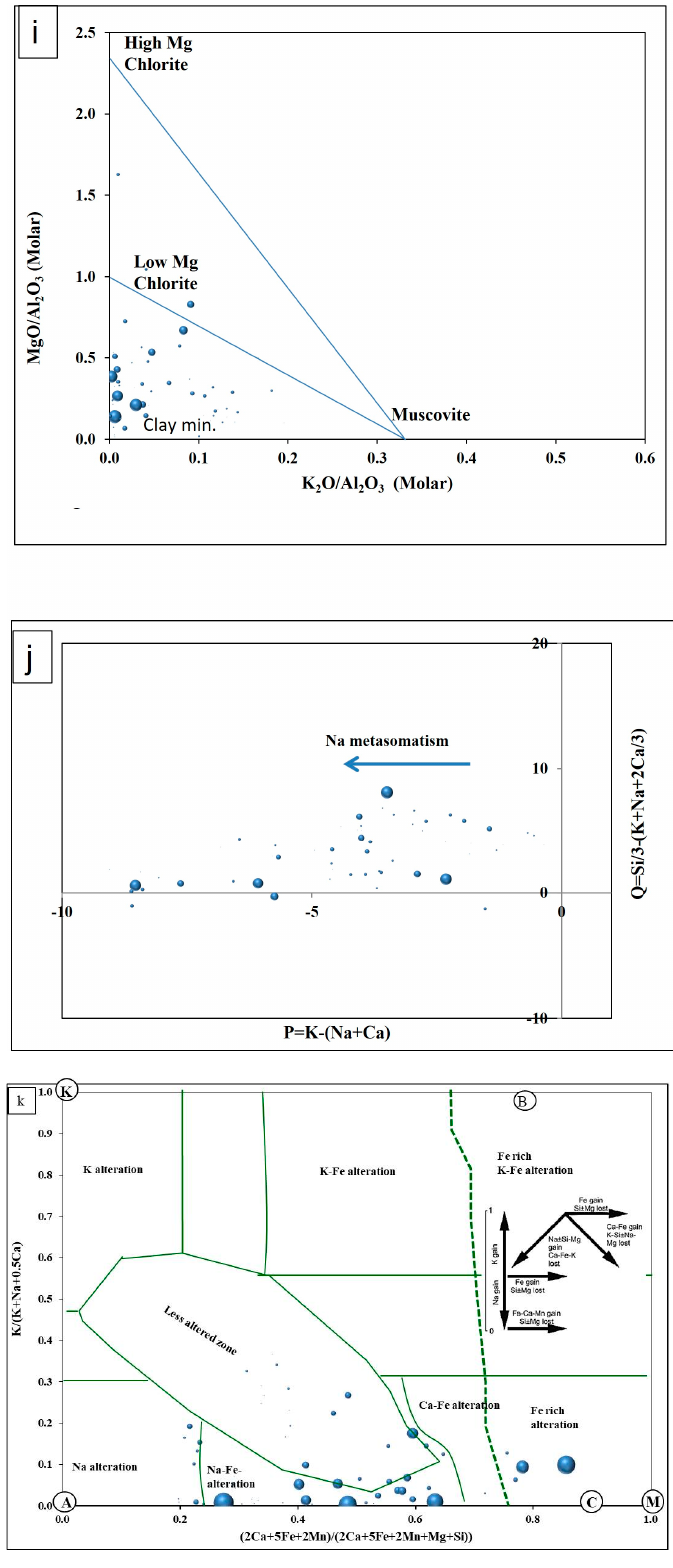
Figure 12. ( a – f ) GER (molar ratio) diagrams. The blue line indicates K-gain and the red line is K-loss. Nodes of albite (A), K-feldspar (K), chlorite (C), muscovite (M), and biotite (B) are shown; ( a ) (Na + K)/Al vs. Na/Al, indicating predominance of albite when compared to chlorite; ( b ) Na/Al vs. K/Al diagram; ( c ) (Na + K)/Al vs. (Fe + Mg)/Al, showing the trend of chloritisation; no sample is fully devoid of Na and K; ( d ) the degree of albitisation diagram of K-(Na + Ca)/Al vs. U does